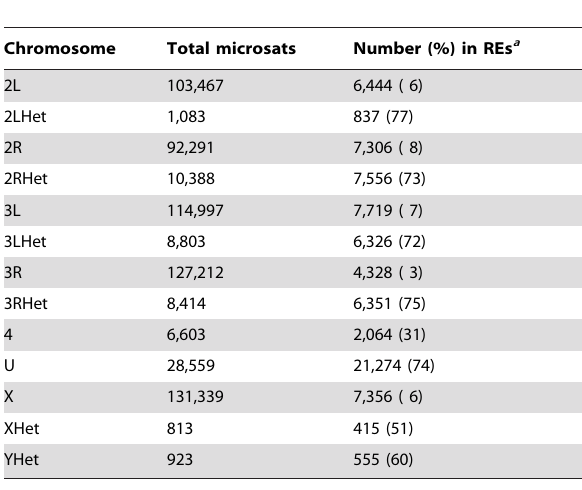
Table 1. Number of identified microsatellites and their association with repetitive elements by